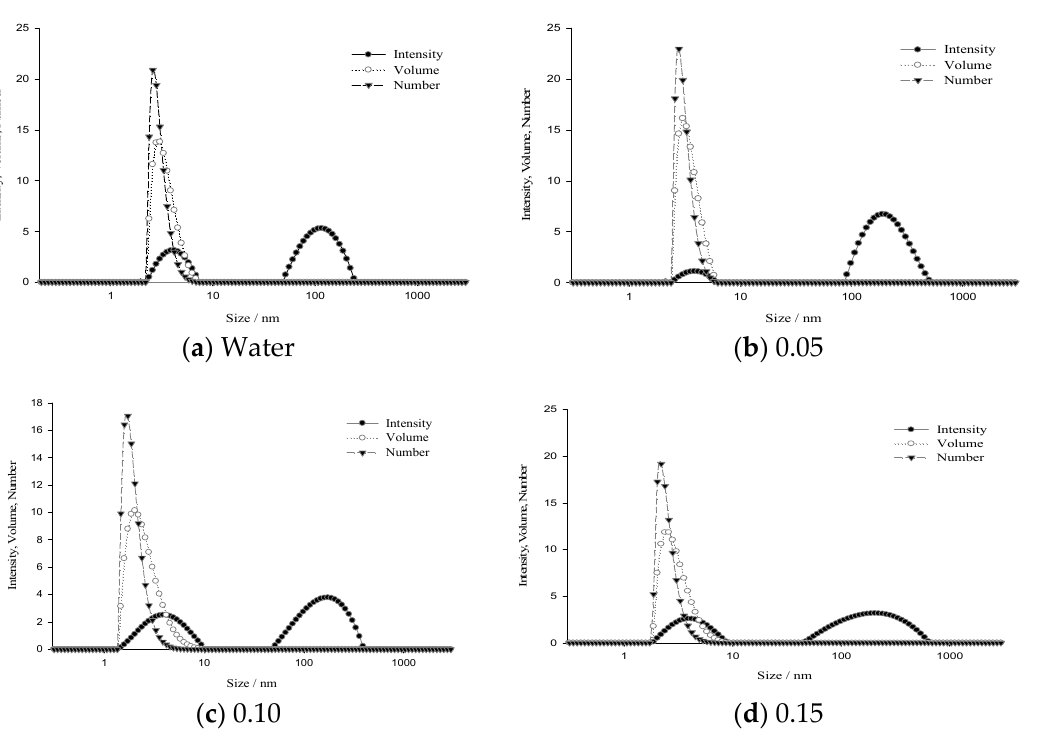
Figure 2. Dynamic light scattering (DLS) measurement of the size distribution of SDS (0.01 mol dm − 3 SDS solution) in the binary mixture of water and ( a ) 0 mass fraction of propane-1,2-diol, ( b ) 0.05 mass fraction of propane-1,2-diol, ( c ) 0.10 mass fraction of propane-1,2-diol and ( d ) 0.15 mass fraction of propane-1,2-diol.